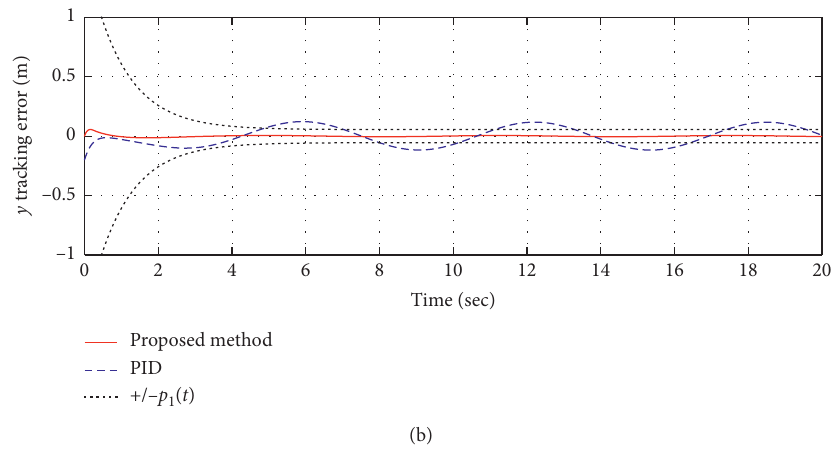
Figure 7: The tracking trajectory of y